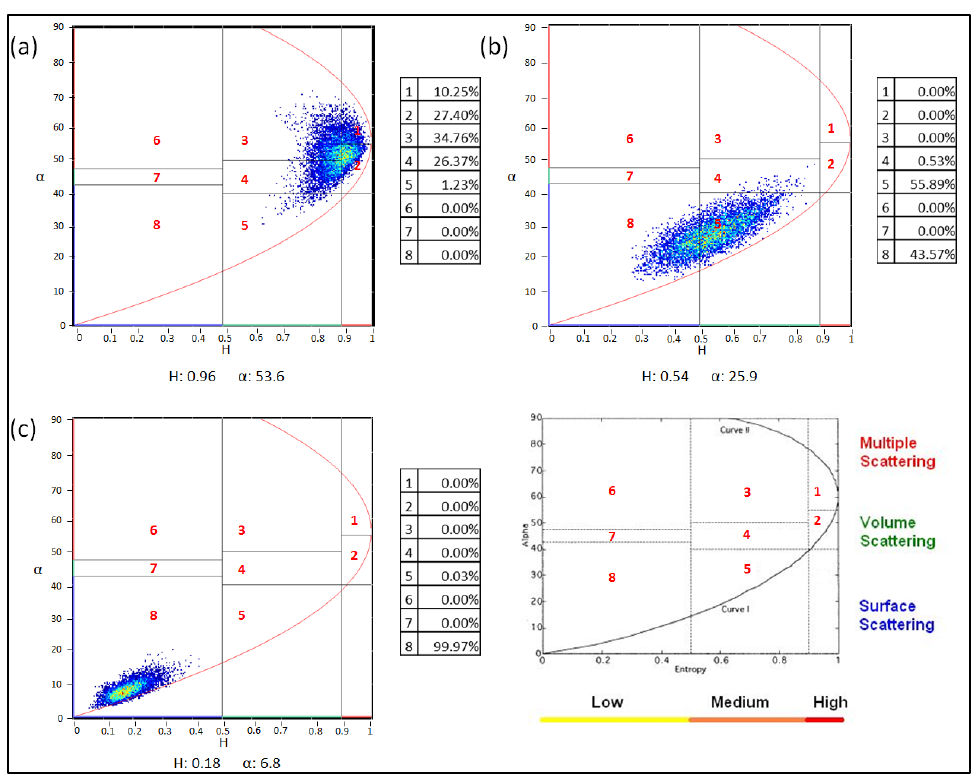
Figure 13. Surface water Cloude-Pottier H/α decomposition based on RADARSAT-2 fine-quad beam modes for ( a ) 20 June; ( b ) 7 August; and ( c ) 21